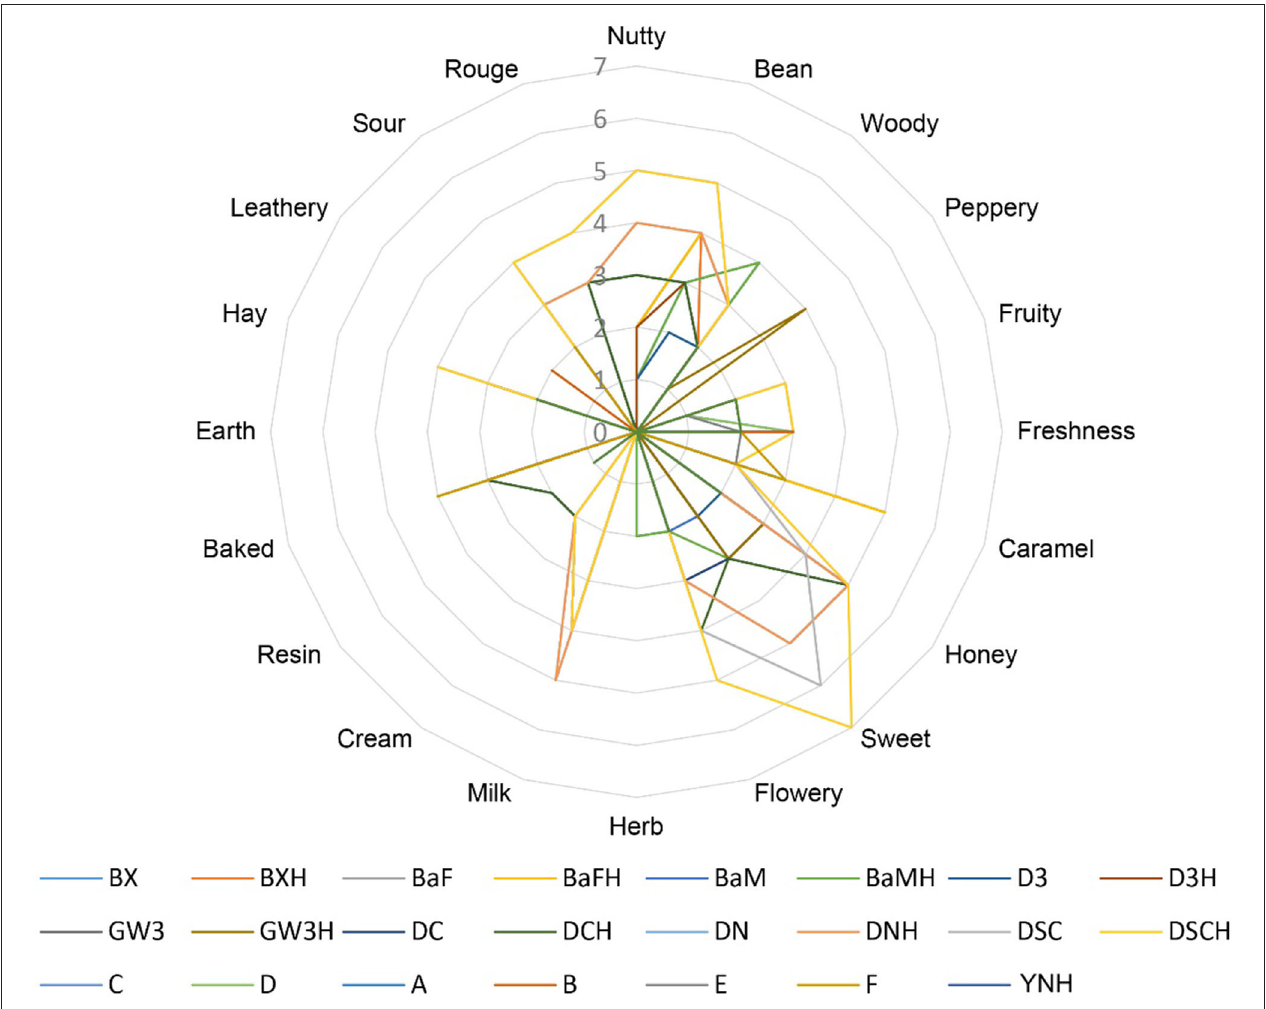
FIGURE 7 | Graph of the sensory score of cigar tobacco